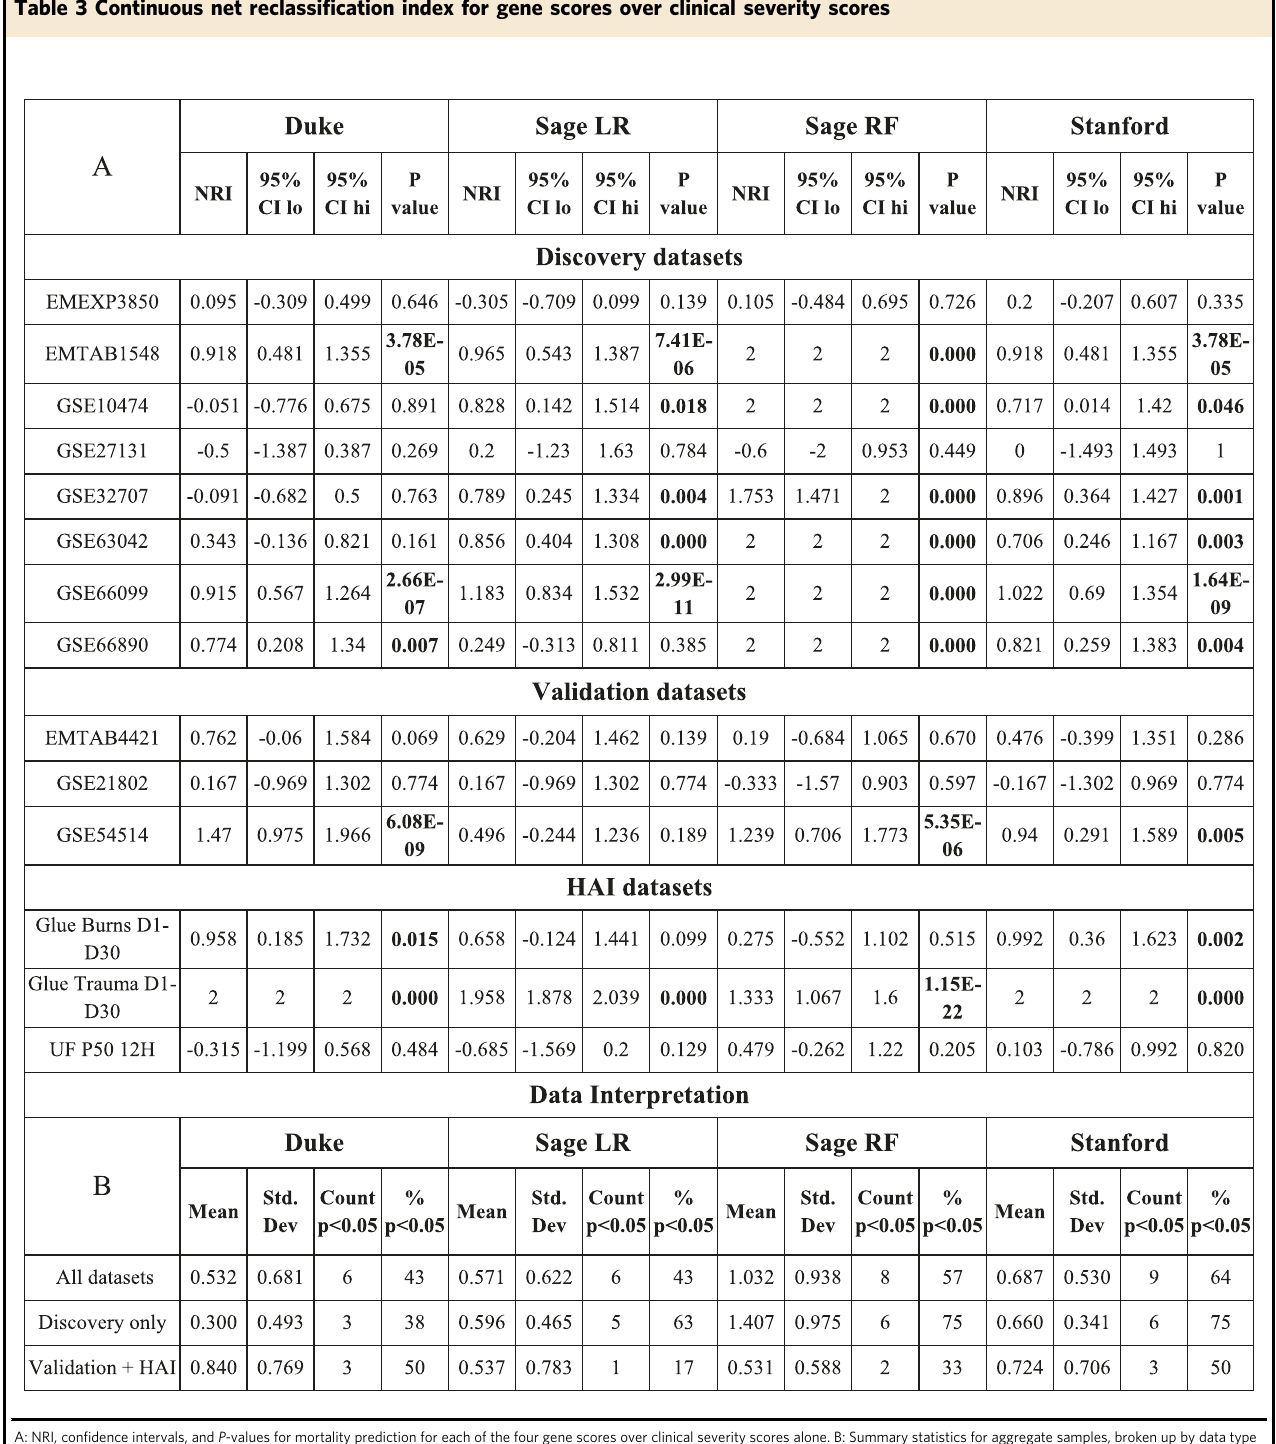
Table 3 Continuous net reclassi fi cation index for gene scores over clinical severity